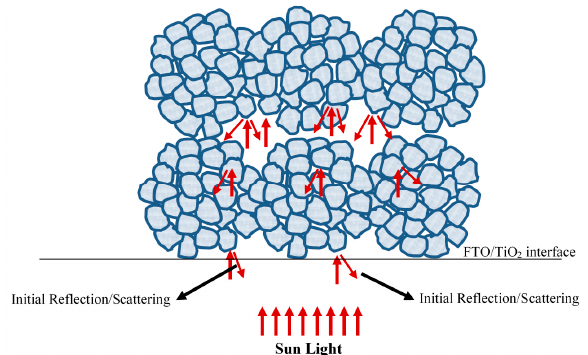
Figure 6. Schematic depicting the expected scattering e ff ects in the DSSC device fabricated using the S3